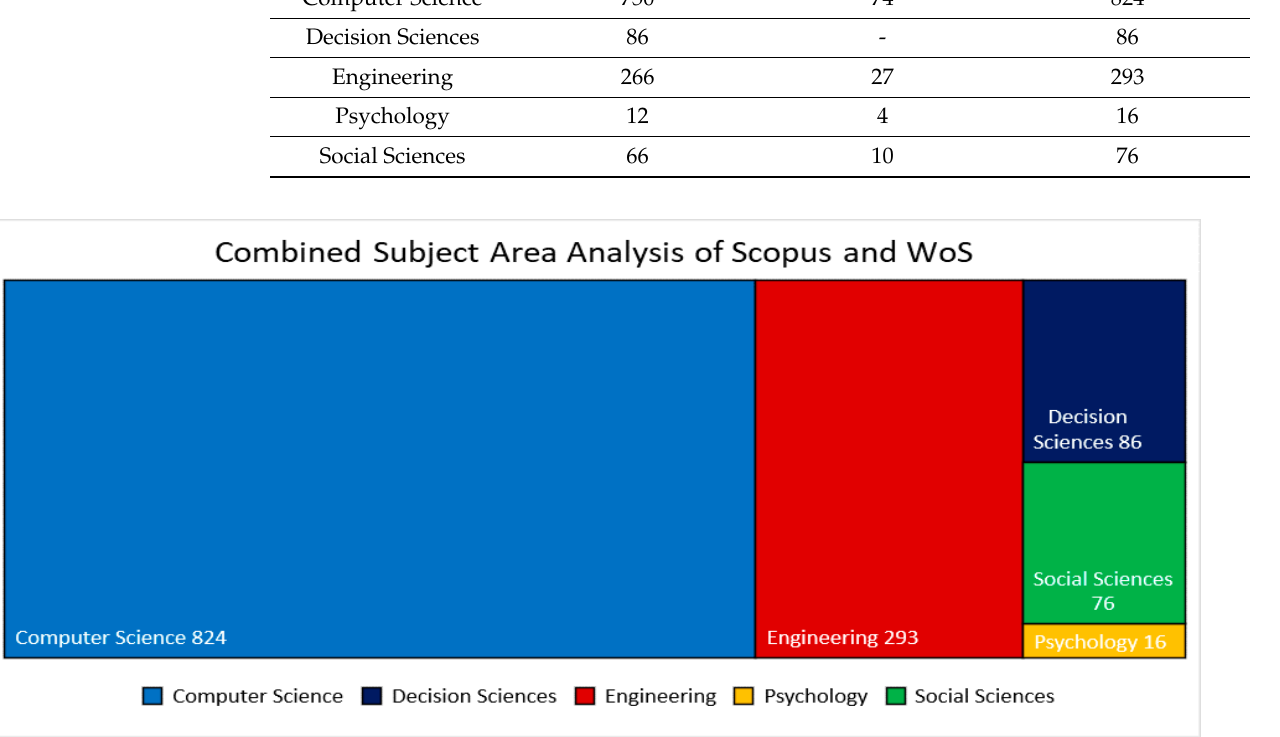
Table 10. Prominent funding agencies combined from Scopus and Web of Science.